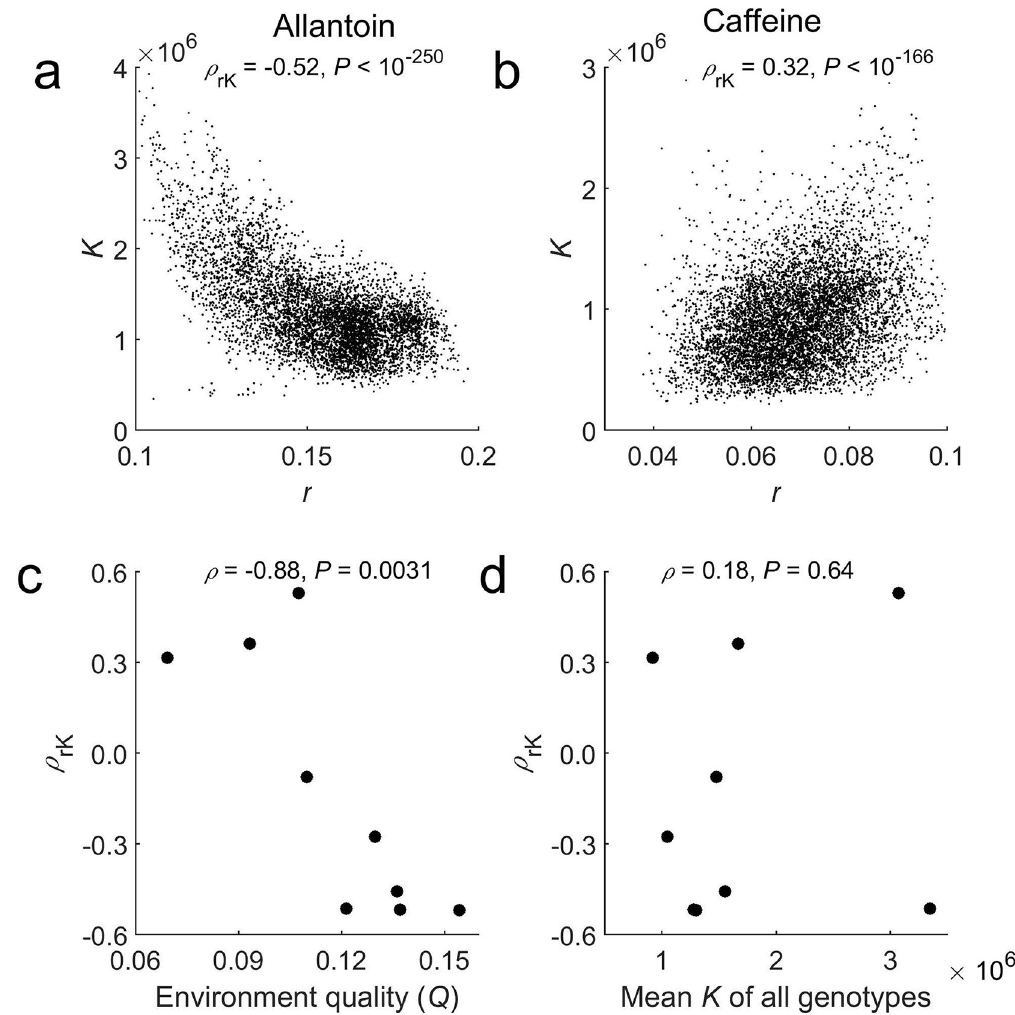
genotype. The rank correlation ( ρ rK ) between r and K among all genotypes and the associated P -value are presented. ( c ) ρ rK decreases with environment quality Q , which is the mean r of all genotypes in the environment. ( d ) ρ rK is not significantly correlated with the mean K of all genotypes in the environment. In (c) and (d), each dot represents one environment. The among-environment rank correlation ( ρ ) between ρ rK and either Q or mean K are presented. Data are available at